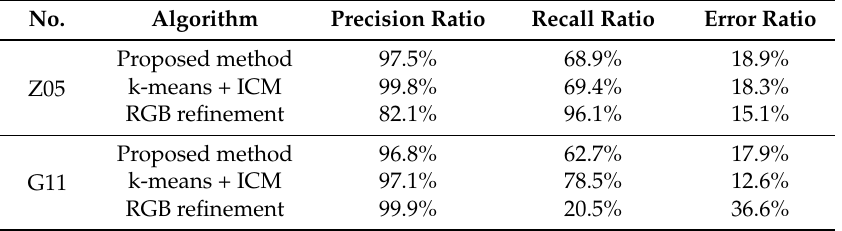
Table 7. Quantitative comparison with other algorithms in our failed